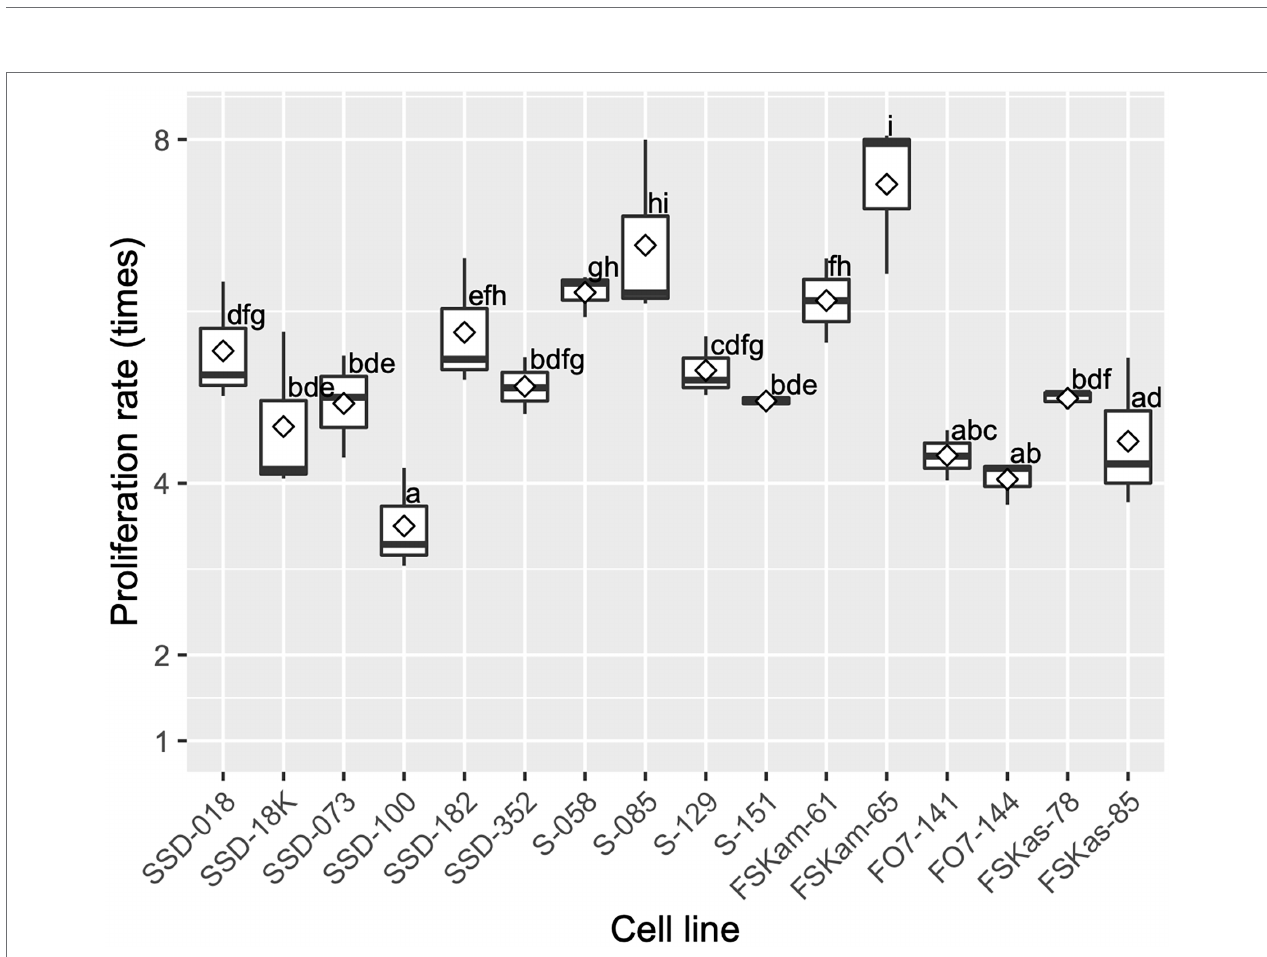
FIGURE 6 | Embryogenic cell proliferation efficiency for different cell lines of pollen-free sugi ( C. japonica ) derived from four seed families (proliferation rate average ± SD for each cell line). SSD: “Shindai 3” × “Suzu 2” (2016); S: “Shindai 3” × “Suzu 2” (2017); FSKam: “Fukushima-funen 1” × (“Shindai 3” × “Kamikiri 2”); FO7: “Fukushima-funen 1” × “O ̄ i 7”; and FSKas: “Fukushima-funen 1” × (“Shindai 3” × “Kashiwazaki-shi 3”). The open diamond in the boxplot represents the mean. The different letters indicate significant differences among the cell lines ( p < 0.05, pairwise comparison with BH